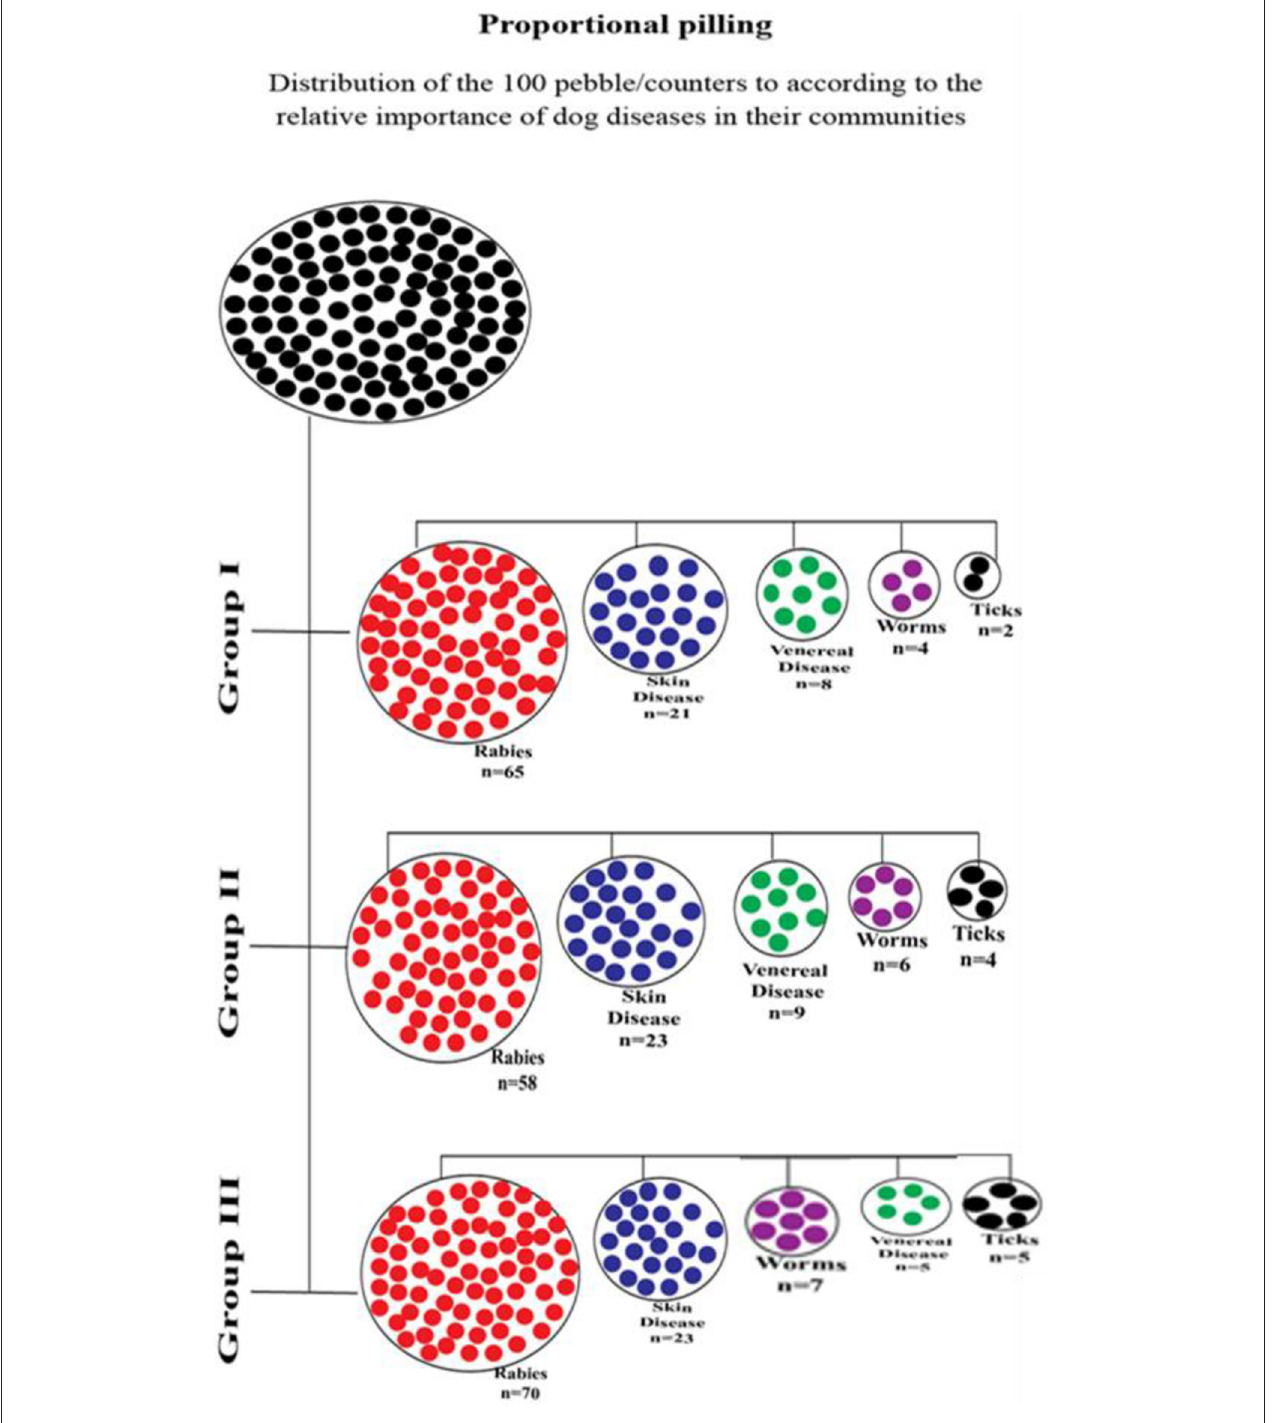
FIGURE 2 | Proportion pilling results on dog diseases from three focus group discussions conducted in Masaka district, Uganda.